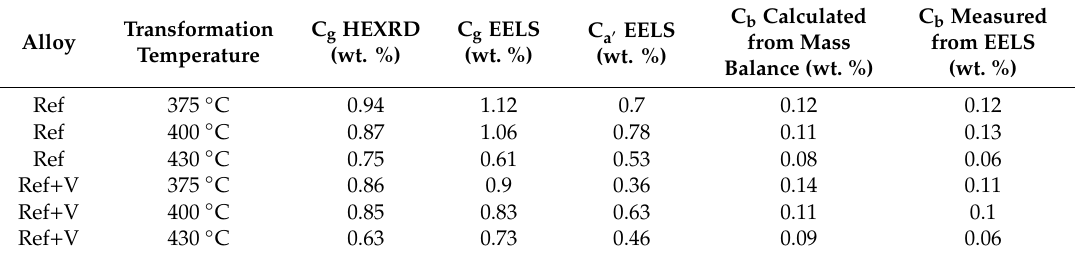
Table 5. Final carbon contents in austenite, martensite and bainitic